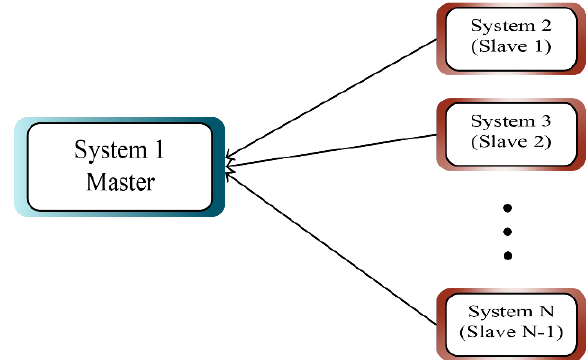
Figure 1. Structure of transmission synchronization.